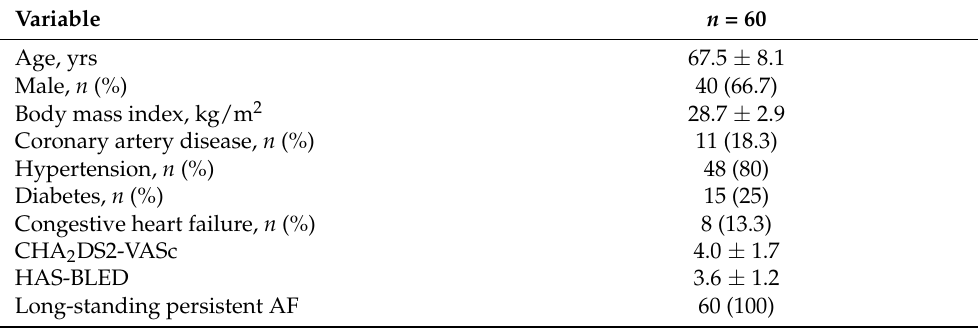
Table 1. Baseline characteristics of the cohort.